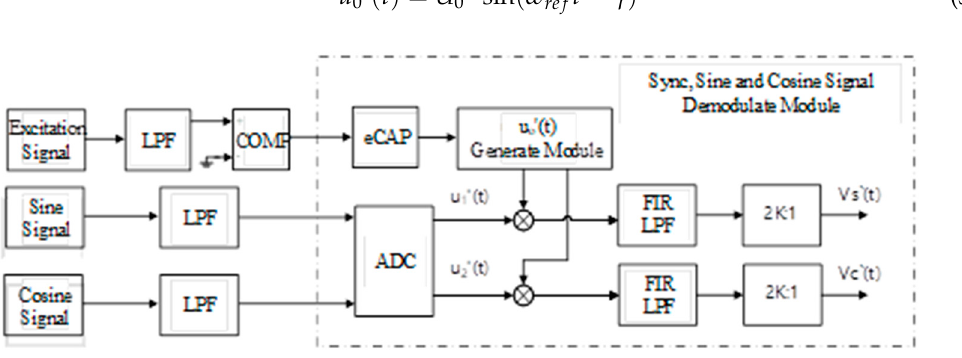
Figure 4. Synchronization, sine and cosine signal demodulation module method